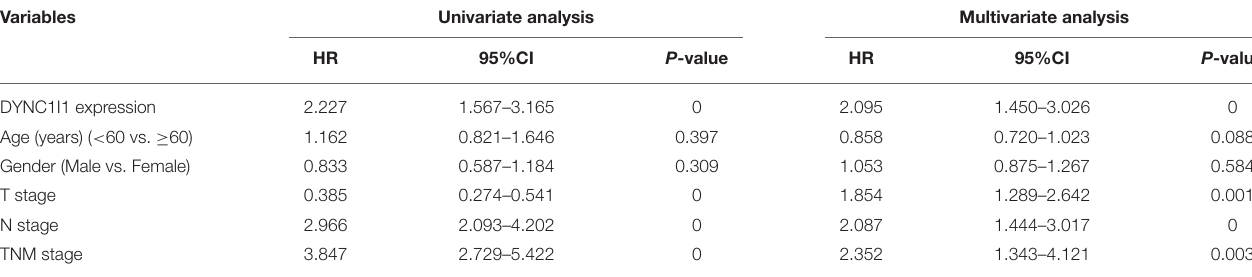
TABLE 2 | Univariate and multivariate OS Analysis in GSE62254 dataset.